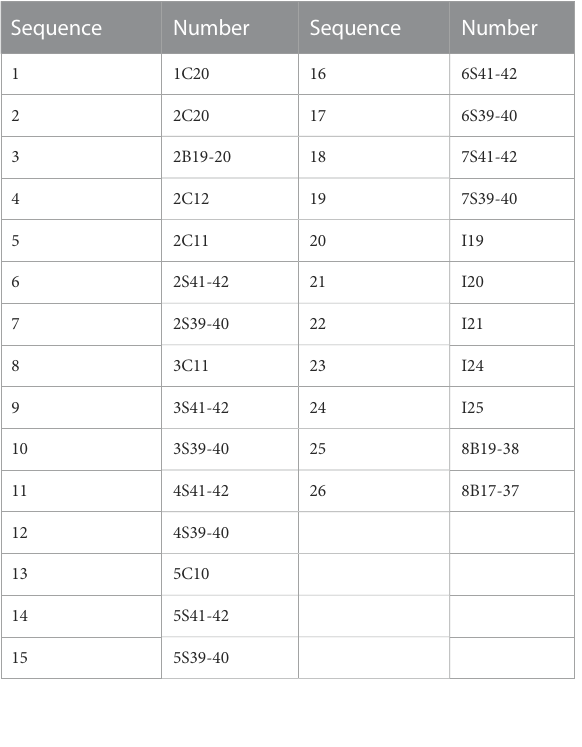
column component and shear wall component, as shown in Figure 11. For instance, column No. 20 on the fi rst fl oor is designated as 1C20, while the beam between column No. 20 and column No. 15 on the second fl oor is designated as 2B15-20.